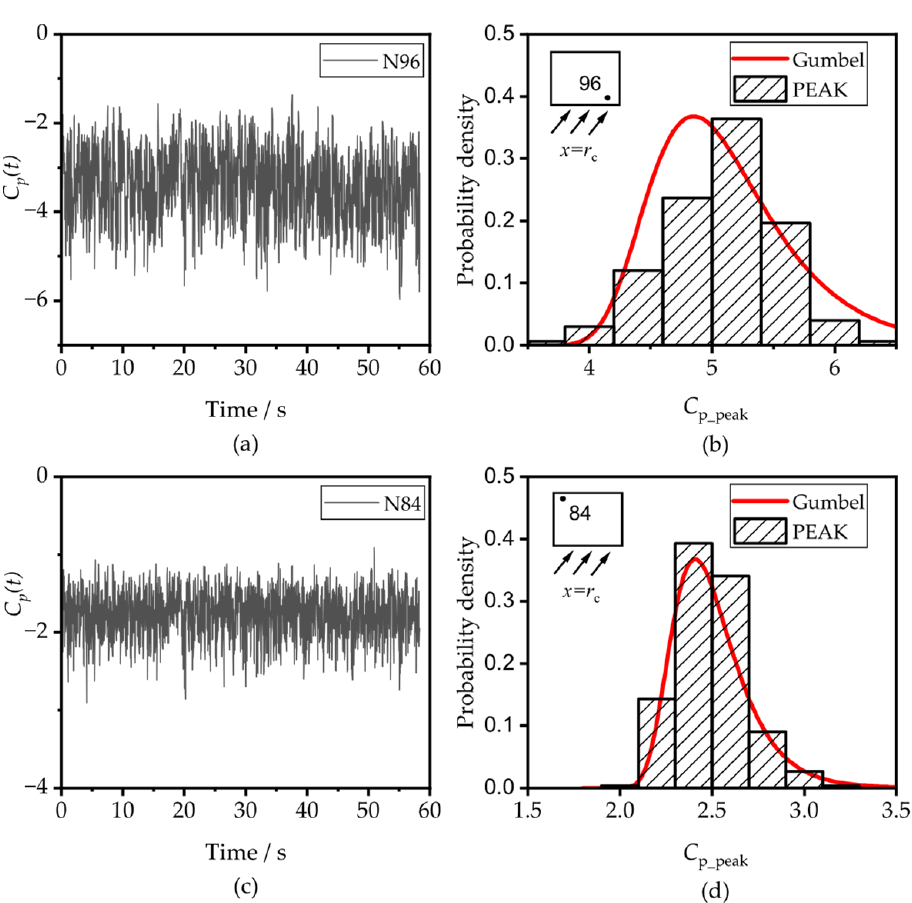
Figure 11. Time series of pressure coe ffi cients and probability density distribution of peaks. ( a ) Time series of pressure coe ffi cients at tap N96; ( b ) probability density distribution of pressure peaks at tap N96; ( c ) time series of pressure coe ffi cients at tap N84; and ( d ) probability density distribution of pressure peaks at tap